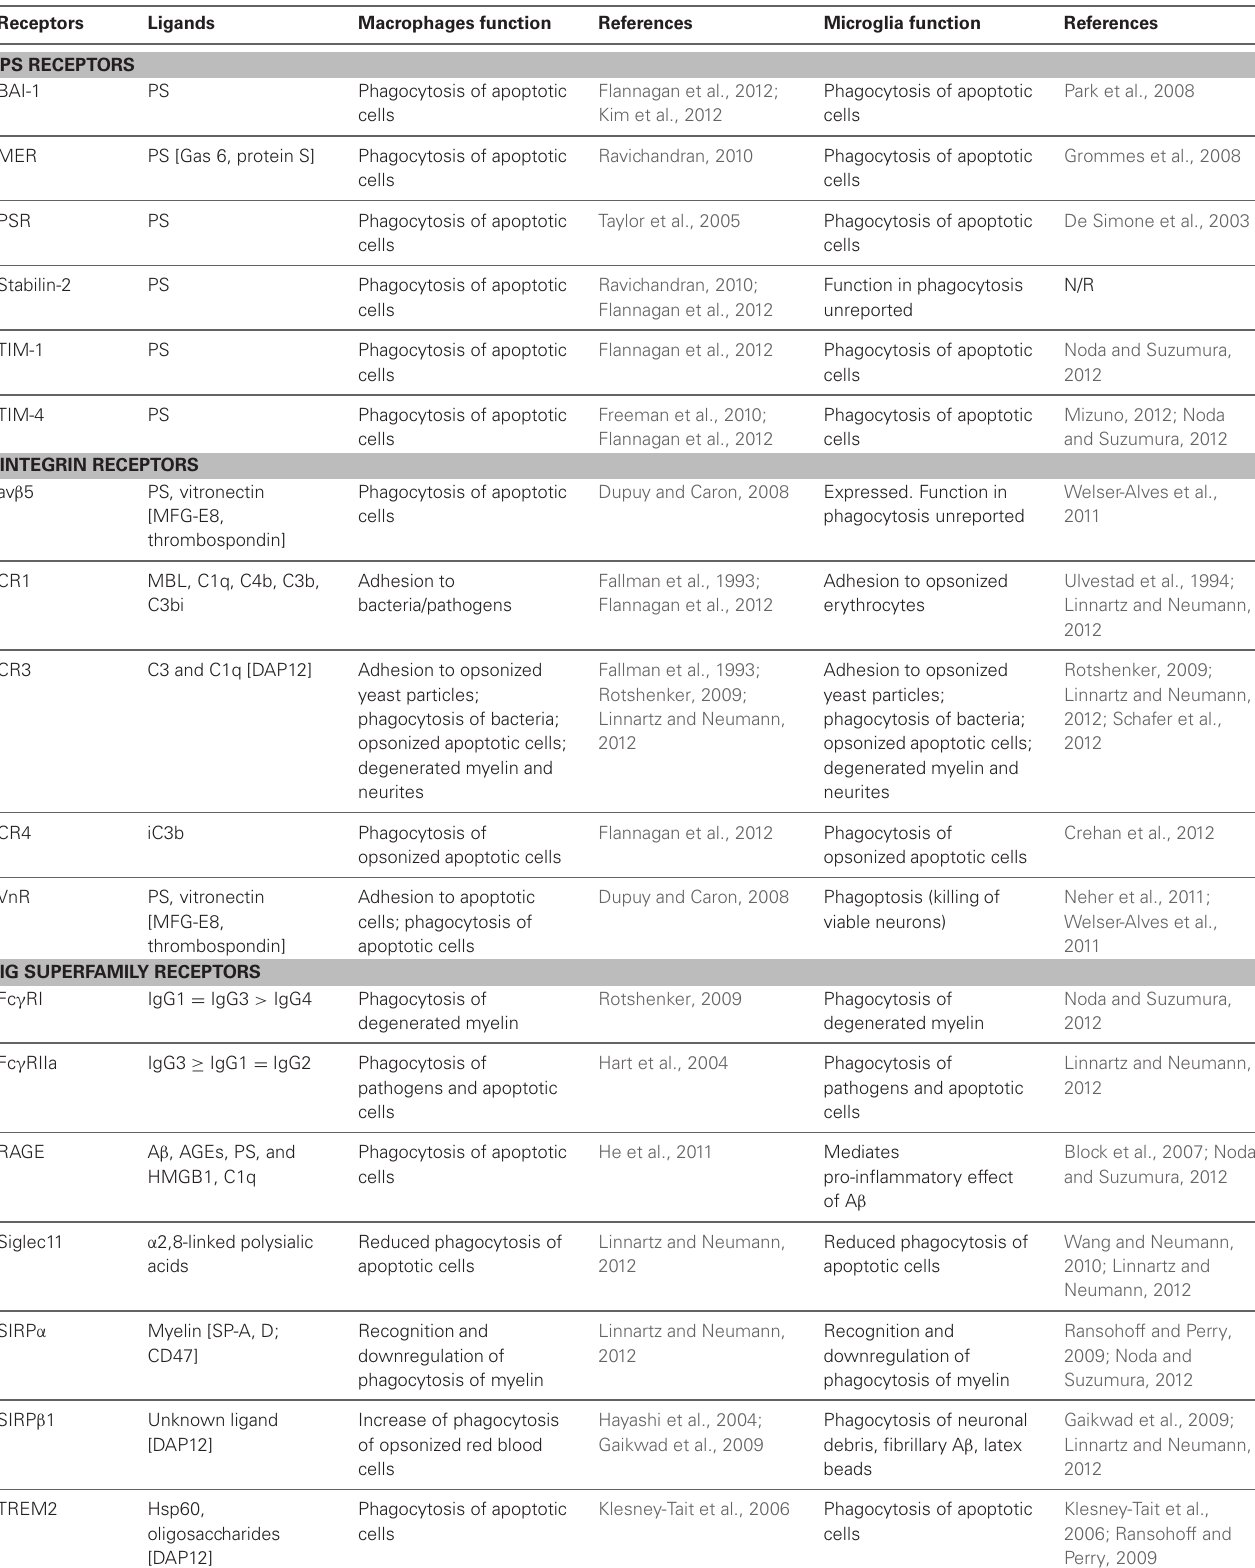
Table 1 | Summary of receptors involved in macrophage and microglial